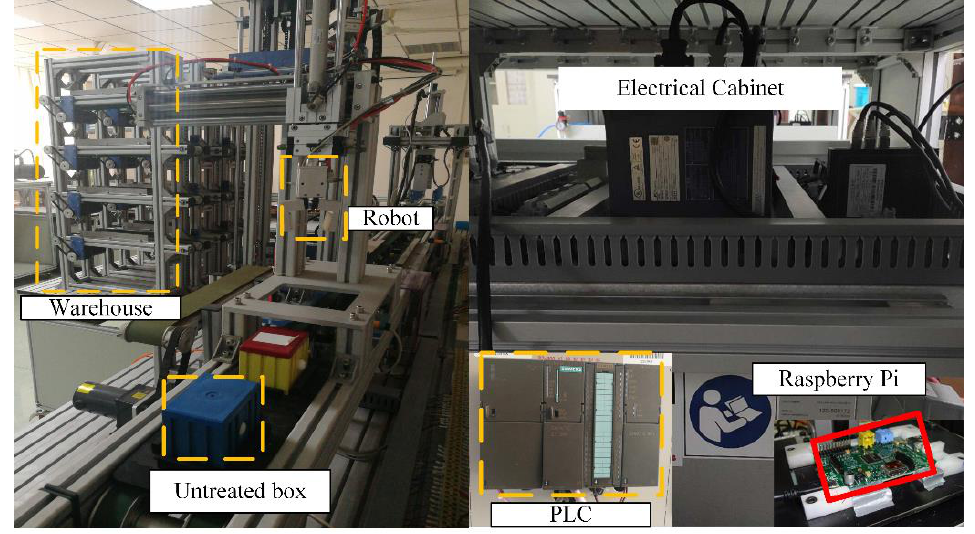
Figure 11. Experimental platform of the case study.